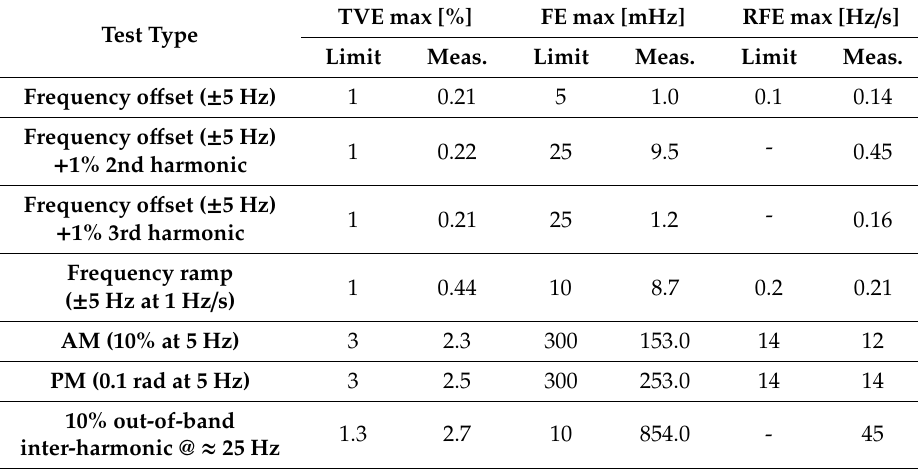
Table 2. Maximum measured (Meas.) TVE, FE and RFE, and the corresponding limit values, in various testing conditions reported in IEEE Standards for Class M PMUs. The reported results refer to observation intervals of four nominal cycles and reporting rate of 50